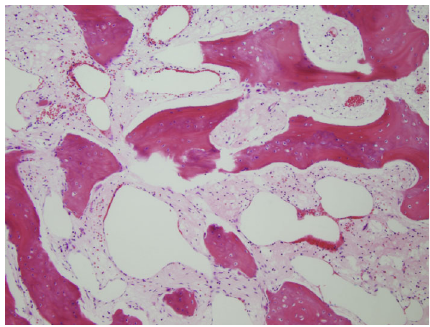
Figure 5: Low-power photomicrograph (original magni fi cation, × 4; hematoxylin & eosin stain) shows dilated thin-walled vessels lined by fl attened endothelial cells extending between scattered reactive bone trabeculae.